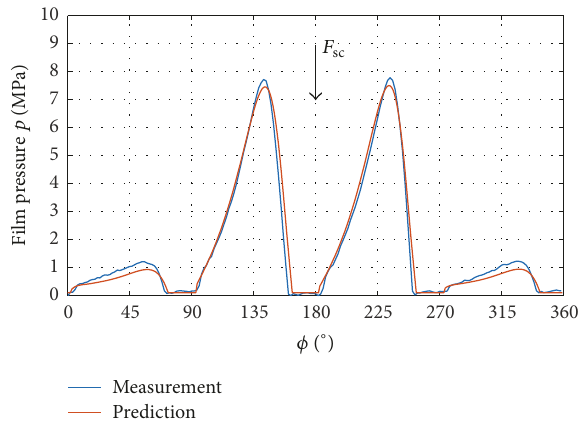
Figure 11: Measured and predicted pressure distribution (TPB120, 𝑛 = 6000 min −1 , 𝑝 = 2.0 MPa, 𝑄 = 90 l/min, 𝑇 𝑞 𝑧 = 36 mm).